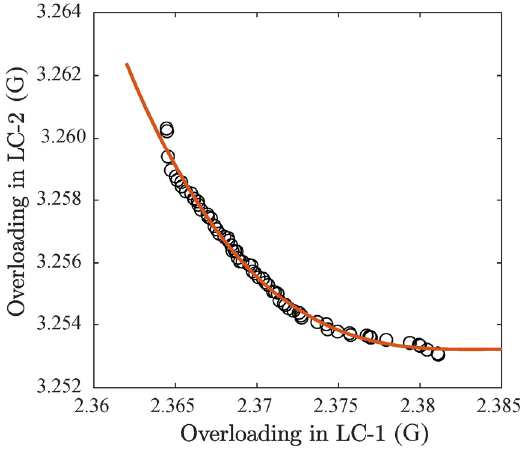
Figure 12. The Pareto front of two optimization goals. Table 10. The optimized values of the landing gear parameters.